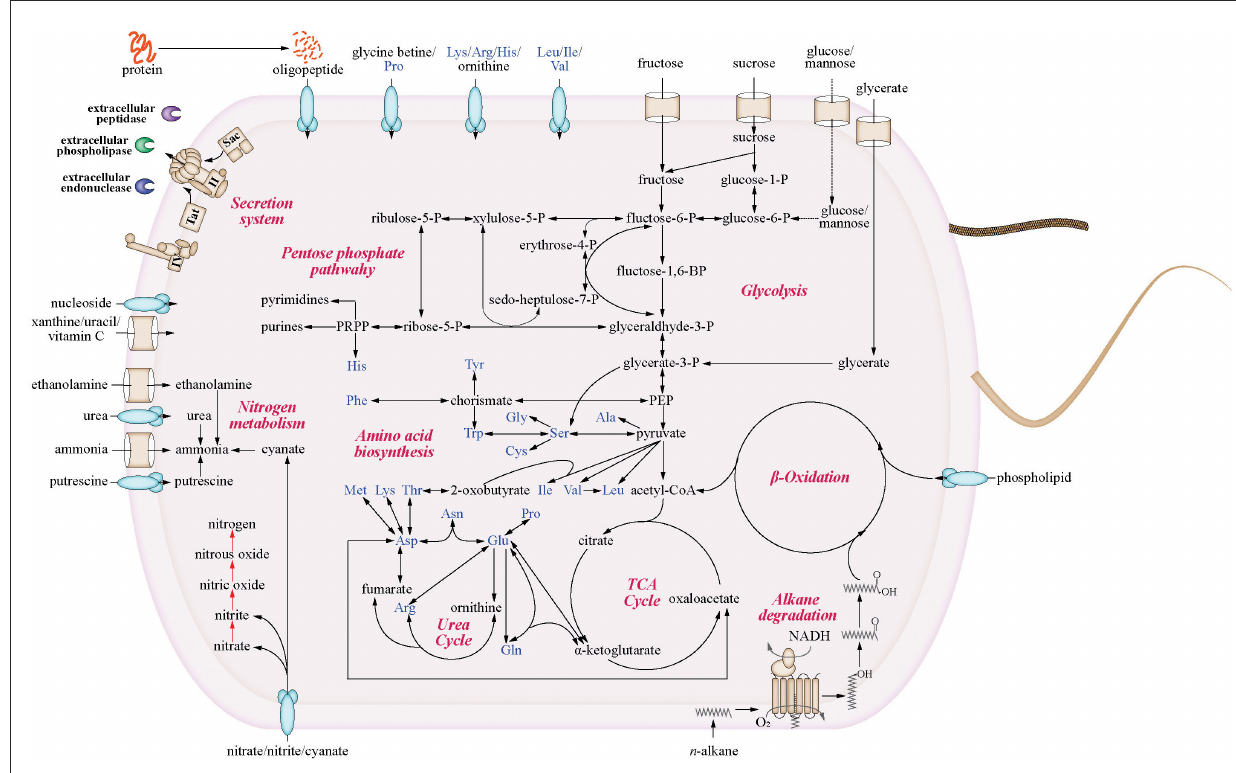
FIGURE3 Metabolic potentials of strain C2-1 and IMCC1826 T . Only the shared pathways of the two strains are shown. The red arrows highlight the genus-specific denitrification pathways that were identified in most genomes of this genus but absent in neighboring